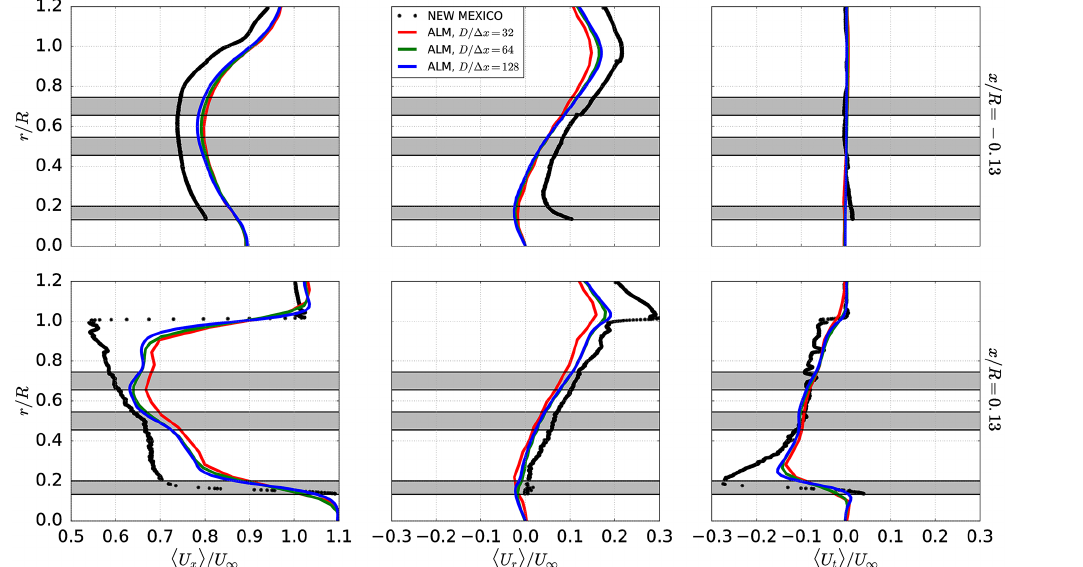
Figure 8. Radial profiles of time-averaged velocity components (cid:104) U x (cid:105) (axial), (cid:104) U r (cid:105) (radial) and (cid:104) U t (cid:105) (tangential) for ALM in different grid resolutions at x/R = 0 . 13.